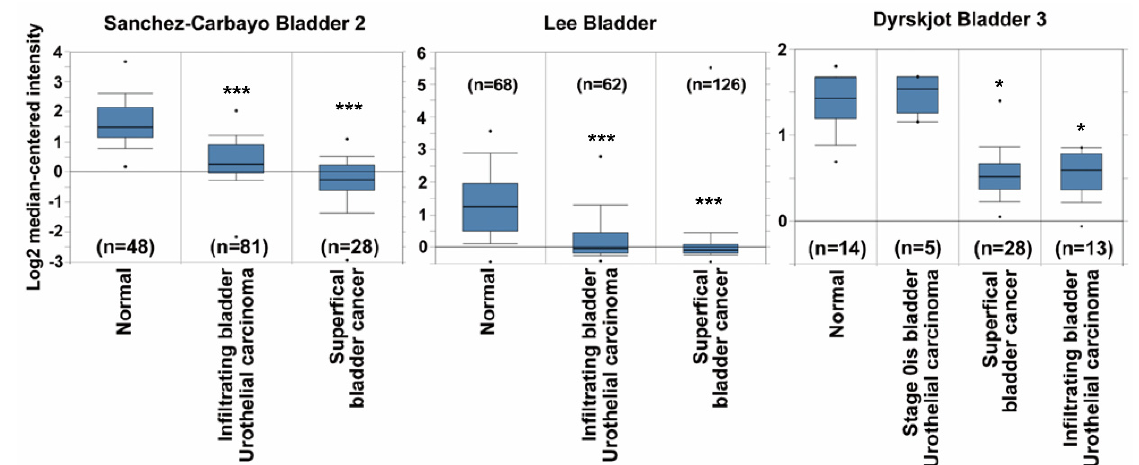
Figure 1. Glutathione S -transferase Mu 5 (GSTM5) mRNA expression is downregulated in patients with bladder cancer from the Oncomine database. Three mRNA databases exhibited different expression levels of GSTM5 mRNA between normal and cancer tissues (left panel: Sanchez-Carbayo bladder 2, middle panel: Lee bladder, right panel: Dyrskjot bladder 3). The dots are the maximum and minimum, the box contains 75% to 25% values, the line in box is median, and the lines outside the box are the values of 90% and 10%. The n means bladder sample number, * p < 1E-7; ** p < 1E-8; *** p < 1E-9 compared to normal.